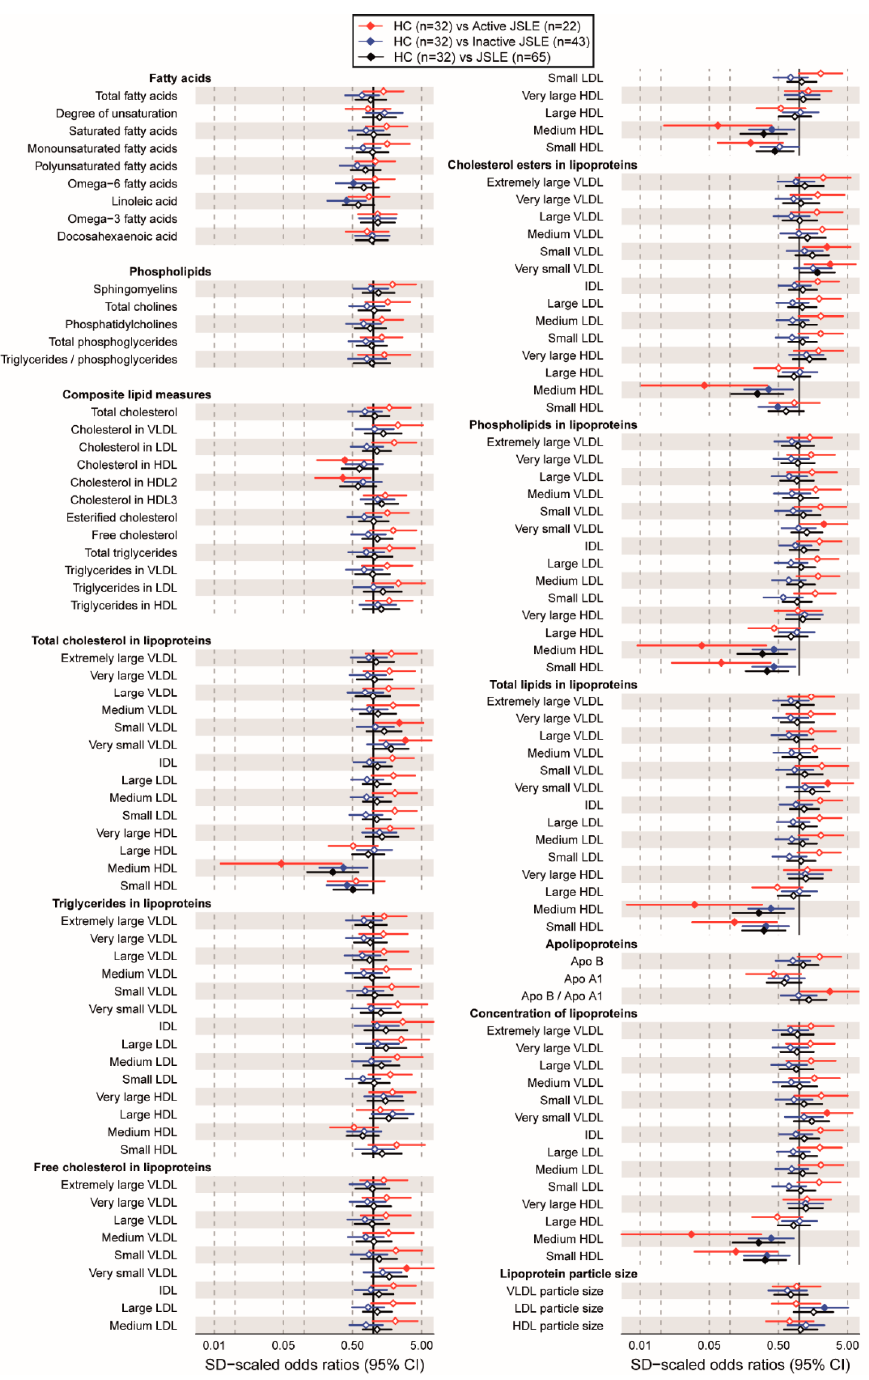
Figure 2. Atherogenic lipoproteins are associated with increased disease activity in JSLE. ( A ) Forest plot showing odds ratios (ORs) and 95% confidence intervals (CIs) of serum lipid metabolites between all JSLE patients ( n = 65), and those with clinically active ( n = 22) and inactive ( n = 43) disease compared to healthy controls (HCs, n = 32) by logistic regression analysis adjusted for age, sex, and race. The concentration of total lipids (mmol/L), apolipoproteins (g/L), and lipoprotein measurements including particle size (nm), concentration, and lipid content (mmol/L) are displayed. Statistically significant differences denoted by solid black diamond; non-statistically significant differences denoted by open diamond. Abbreviations: Apo, apolipoprotein; VLDL, very low-density lipoprotein; IDL, intermediate density lipoprotein; LDL, low density lipoprotein; HDL, high density lipoprotein. HC vs. all JSLE, black line; HC vs. active JSLE, red line; HC vs. inactive JSLE, blue